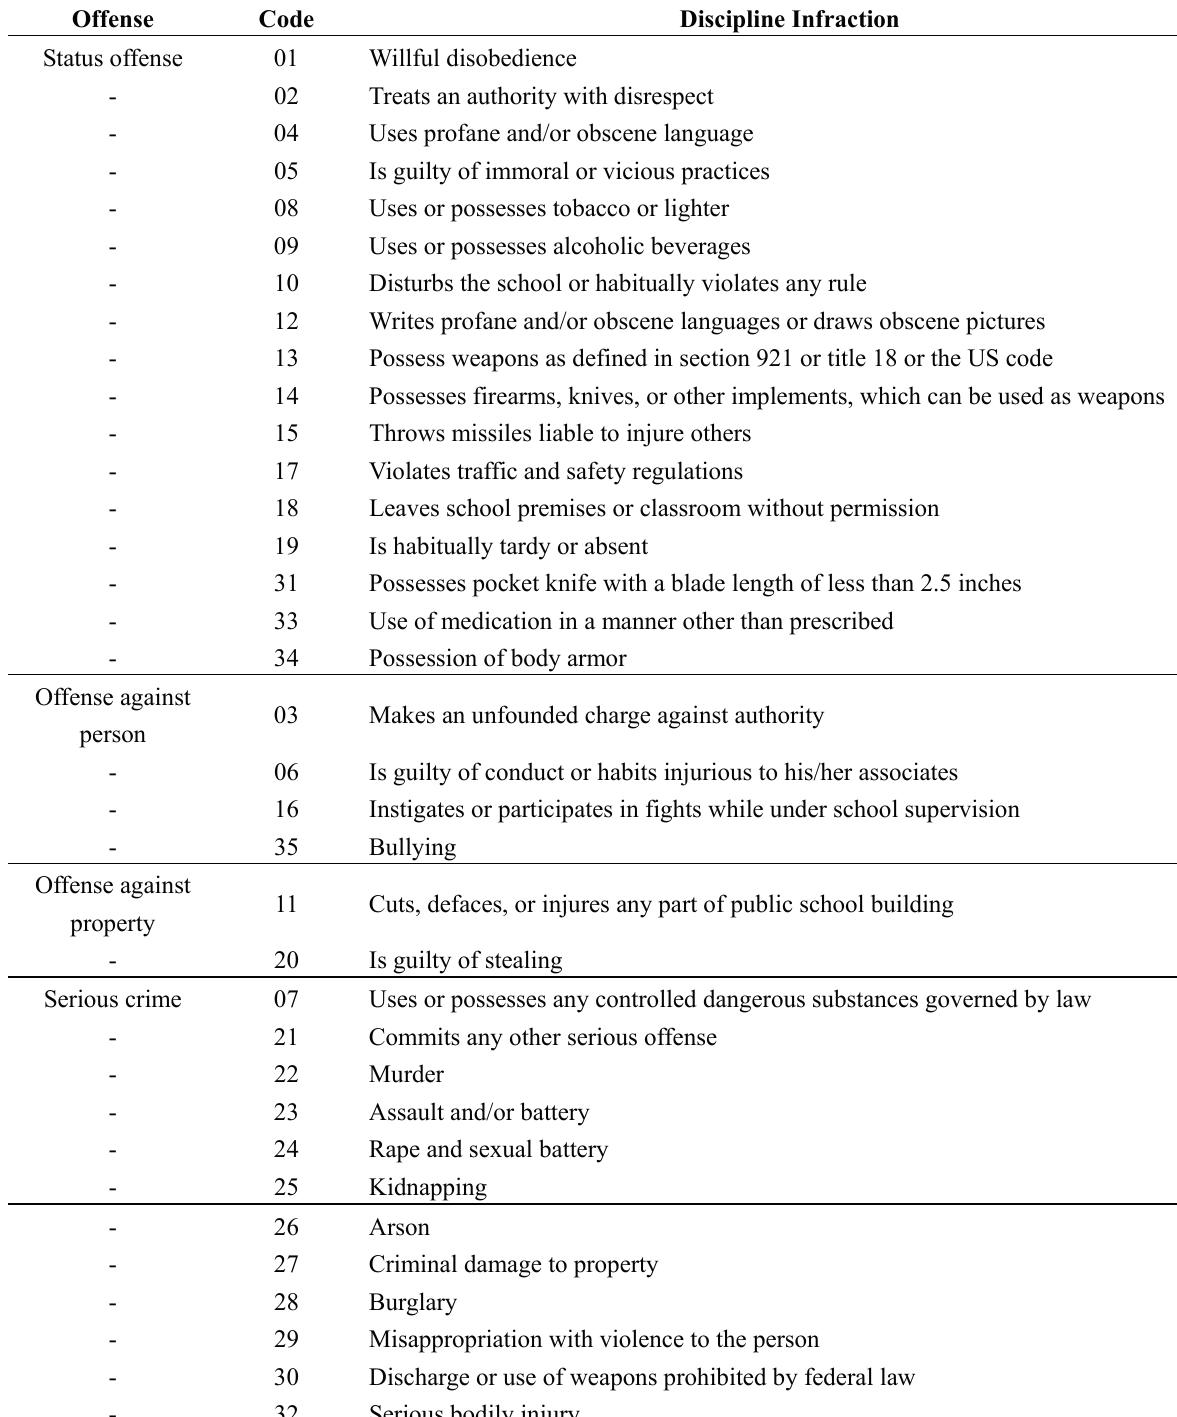
Table 1. Discipline Code and its